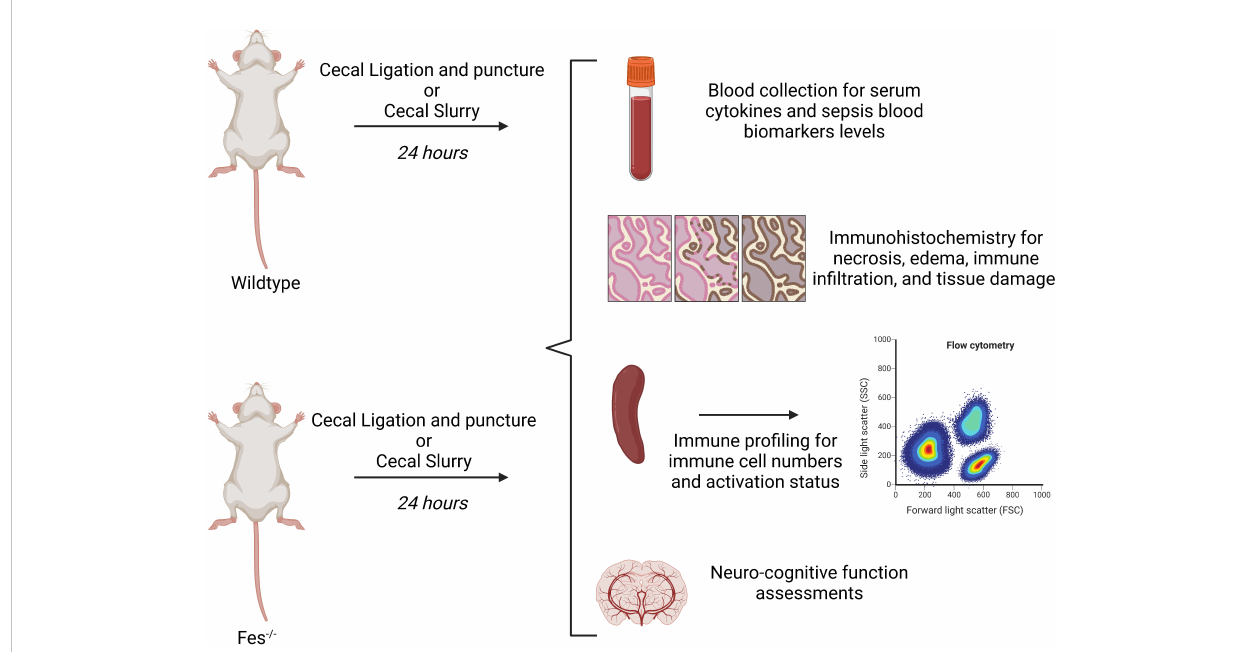
FIGURE 4 Graphical depiction of in vivo methodology. Wildtype (WT) or FES -/- mice will be undergo a cecal ligation and puncture (CLP) or receive a cecal slurry injected intraperitoneally. 24 hours later, mice will be assessed for the following: neurologic function assessment, serum cytokine and biomarker analysis, immunohistochemistry, and spleen immune pro fi ling. The same methodology will be used with the addition of decitabine or lorlatinib. Created with